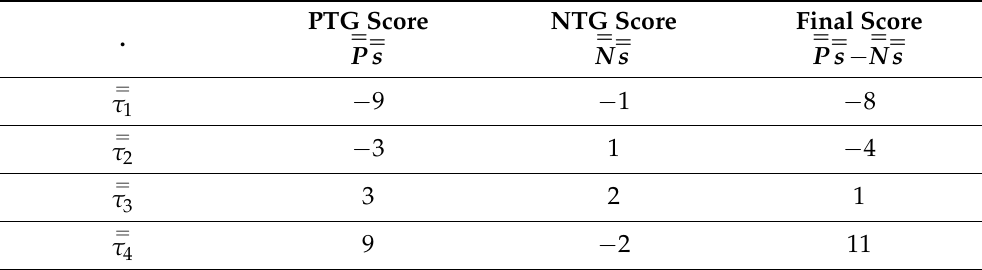
Table 10. Final score table scenario